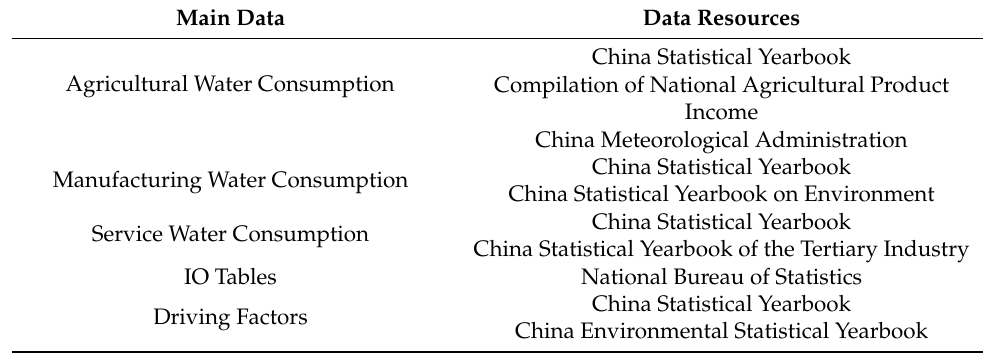
Table 2. Data Resources.